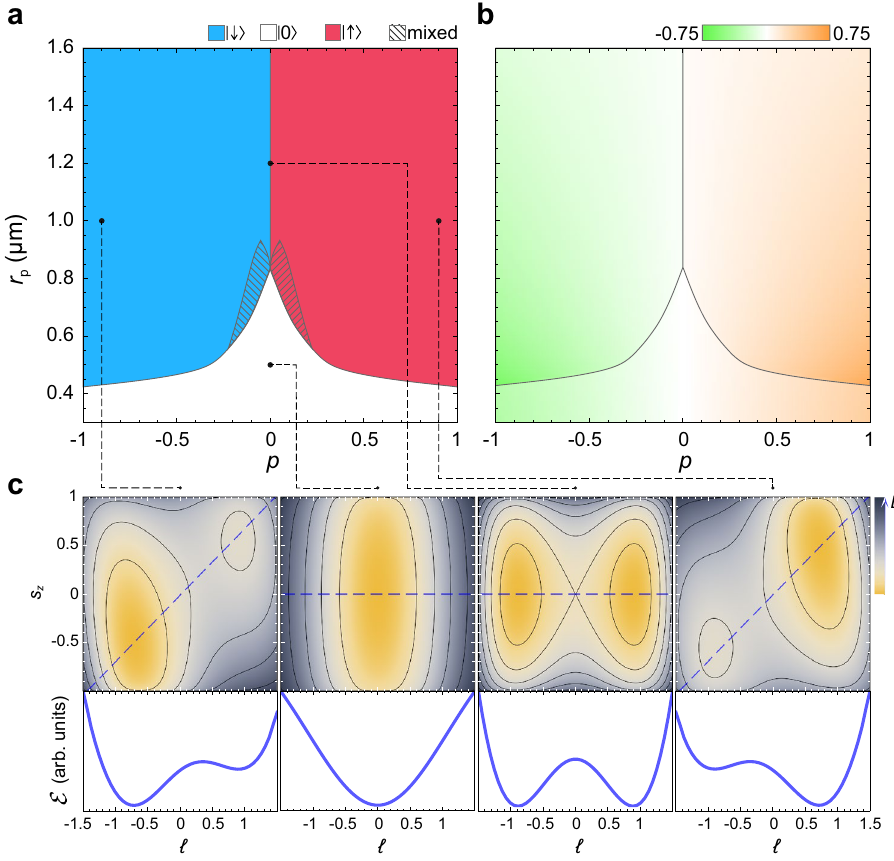
Figure 4. The effect of the pump polarization on the spinor polariton current states. ( a ) The color map showing the variation of the polariton current states | ↑� , | ↓� and | 0 � over the phase plane of the control parameters ( p , r p ) . In the shaded regions the polariton condensate occupies | ↑� and | 0 � (pink shaded) or | ↓� and | 0 � (blue shaded) states in different numerical experiments. ( b ) The dependence of the degree of circular polarization of the polariton condensate, s z , as a function of r p and p . ( c ) Variation of the energy functional, E , with the change of the parameters ℓ and s z for the polariton states indicated in ( a ). The upper panels show variation of E in the plane ( 𝓁 , s z ) . The lower panels show variation of E with the change of ℓ along the dashed line in the corresponding upper